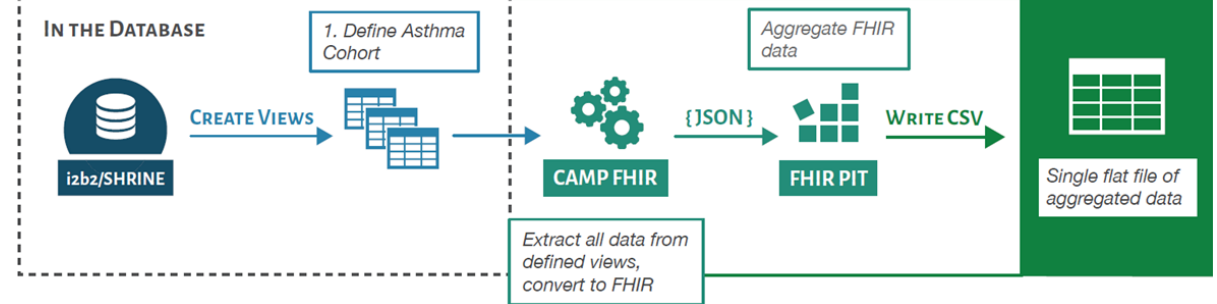
Figure 2. The Clinical Asset Mapping Program fast healthcare interoperability resources (CAMP FHIR) pipeline as used for translator. CSV: comma-separated value; JSON: JavaScript Object Notation; PIT: Patient data Integration